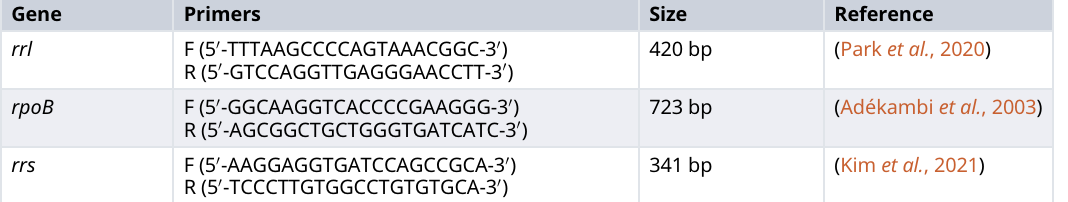
Table 1. Nucleotide sequence of primers for rrl , rpoB and rrs